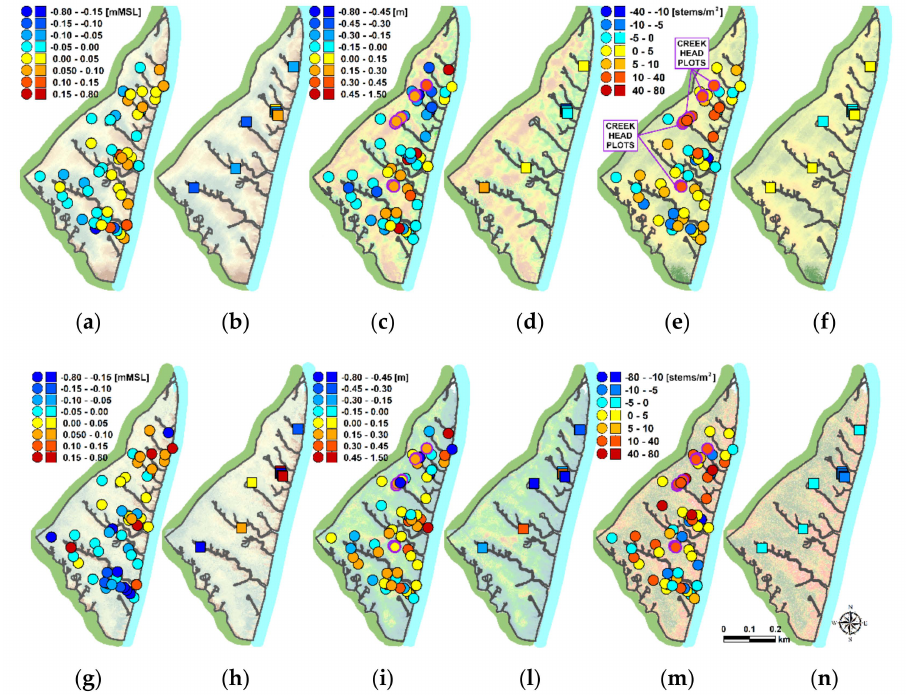
Figure 7. Spatial distribution of the estimation error for: ( a , b , g , h ) ground elevation (in meters above the MSL), ( c , d , i , l ) vegetation height (in meters), and ( e , f , m , n ) vegetation density (in stems m − 2 ), calculated on the plots surveyed on the marsh platform (circles) and the tidal creeks (squares) by using the LiDAR- (first row) and the Digital Aerial Photogrammetry (DAP)-UAV (second row) point clouds. Blue- and red-scale markers indicate underestimation and overestimation of the considered variable, respectively, in comparison with the surveyed value. The purple-bounded dots indicate the plots placed in the unvegetated creek heads (see Section 2.2.2). The green and teal boundary recall the vegetated salt marsh and the main channel adjacent to the study